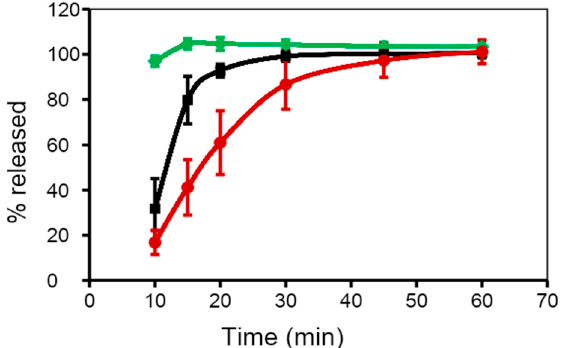
Figure 5. Dissolution profiles of loratadine drug products formulated using different concentrations (in %) of the fill materials using the USP dissolution apparatus 1 (basket) at 75 rpm in 0.1 N hydrochloric acid (HCl) in purified water, ( (cid:4) ) MCM to MCT (50:50), ( (cid:4) ) MCM to MCT (75:25), ( • ) MCM to MCT (100:0). Each data point represents the average ± standard deviation ( n = 6). Reproduced with permission from [63], Dissolution Technol., 2006 .